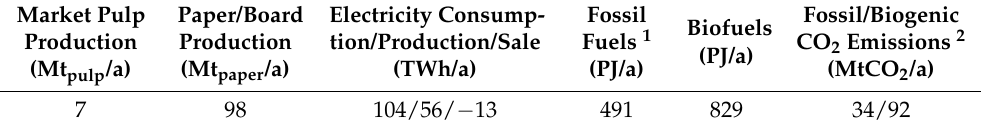
Table 1. Current status of the European pulp and paper industry. Data from CEPI